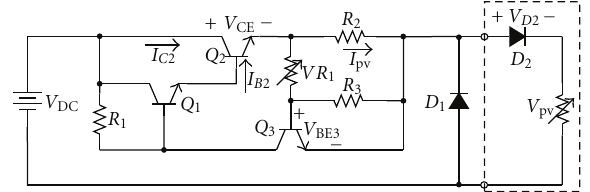
Figure 5: A test circuit for output characteristic simulation by a module simulator. Table 1: Electrical specification for a SANYO HIP 2717 photo- voltaic